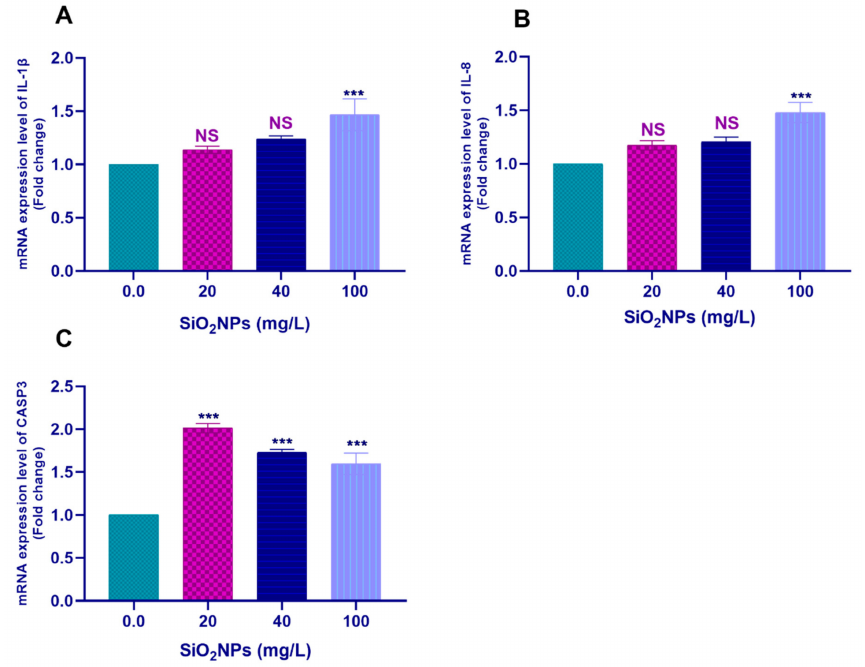
Figure 5. Transcription profile of the ( A ) IL-1 β , ( B ) IL-8 , ( C ) CASP3 genes in the hepatic tissues of Nile tilapia juveniles after exposure to SiO 2 NPs at different concentrations (0.0, 20, 40, and 100 mg/L) for 21 days. The values are expressed as mean ± SEM ( n = 9). Asterisks (***) ( p < 0.001) indicate significant differences between the exposure groups compared with the control group. NS indicates non-significant